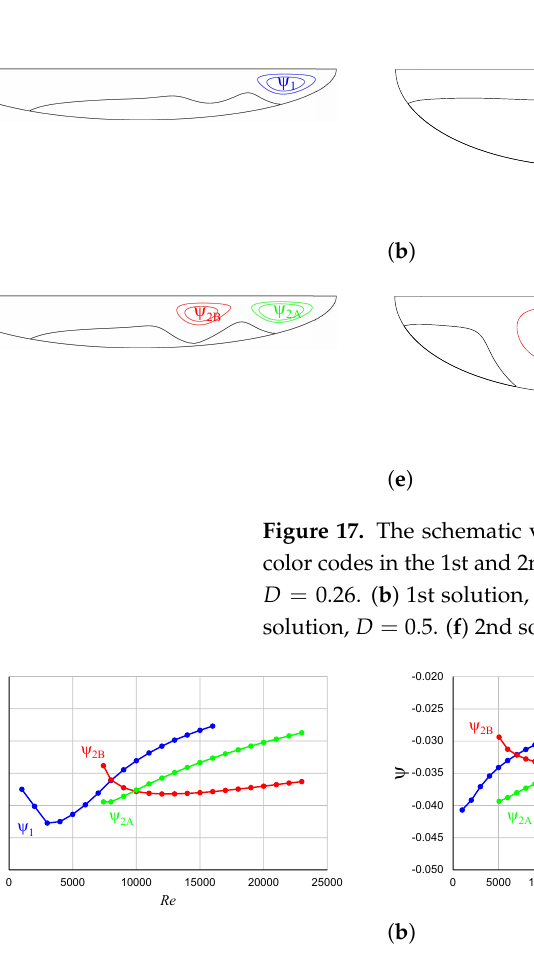
Figure 18. Variation of streamfunction values at the center of the local vortex centers in 1st and 2nd solutions with respect to the Reynolds number with color codes blue, red and green. ( a ) Streamfunc- tion ( ψ ) values, D = 0.26. ( b ) Streamfunction ( ψ ) values, D = 0.5. ( c ) Streamfunction ( ψ ) values, D =